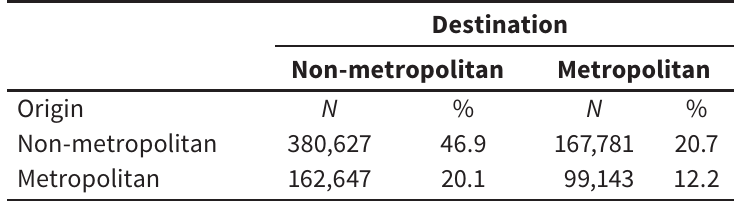
Migrants between metropolitan and non-metropolitan microregiões between 2009 and 2010 Destination Non-metropolitan